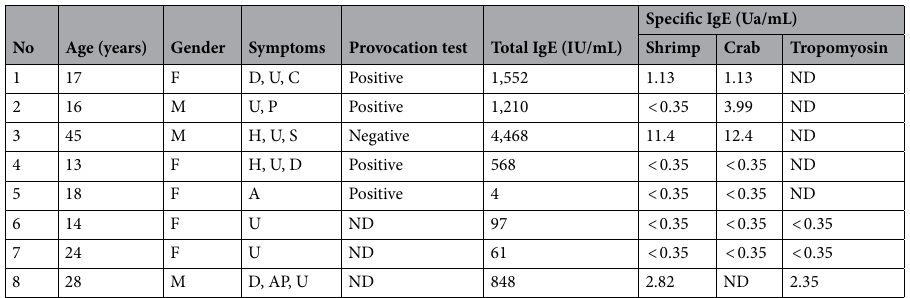
Table 1. Clinical characteristics of patients with shrimp-FDEIA. Serum IgE reactivity to shrimp and crab proteins was analyzed by CAP-FEIA. M, male; F, female; ND, not determined. D, dyspnea; U, urticaria; C, cough; P, pruritus; H, headache; S, shock; A, anaphylaxis; AP, abdominal pain.